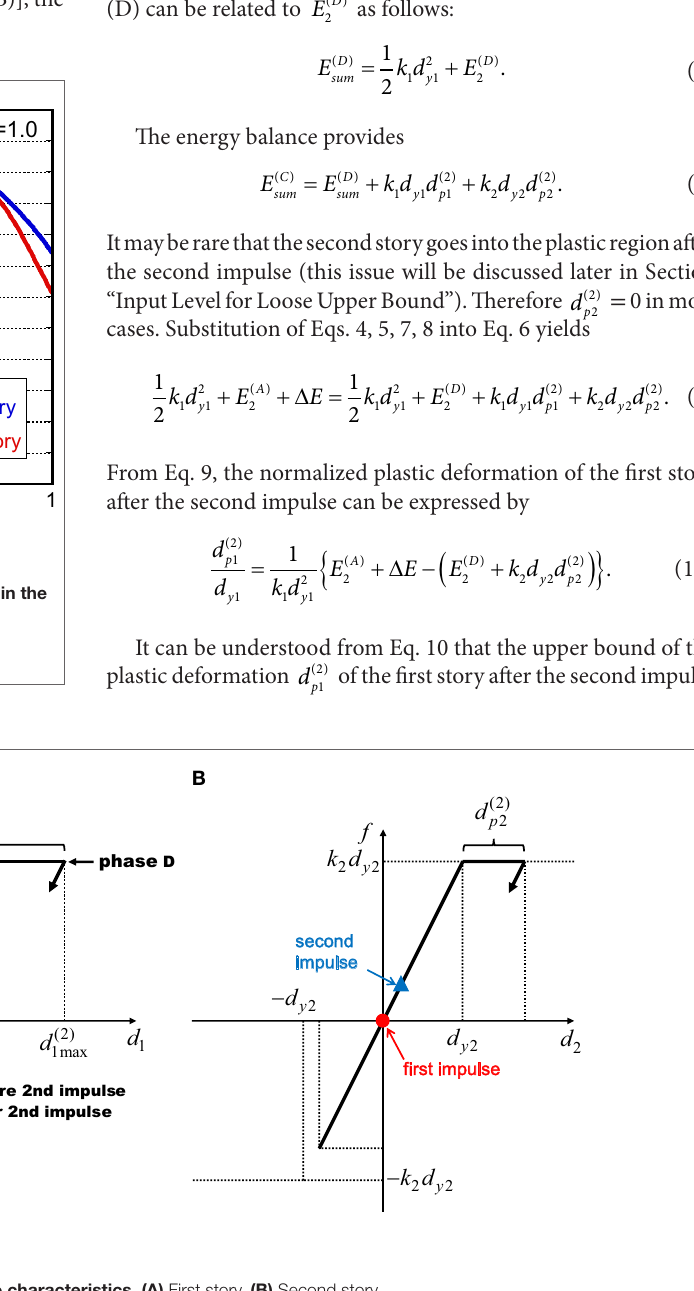
FigUre 4 | Key phases (a), (B), (c), and (D) in the restoring-force characteristics. (a) First story. (B) Second